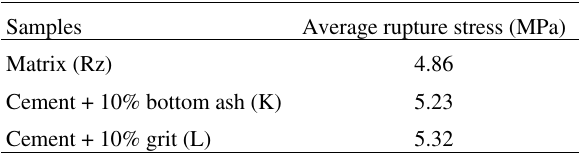
Table 6. Average strength of the samples produced with CPII-Z-32 Portland cement after 28 days of aging. Amount of waste in volume (%).